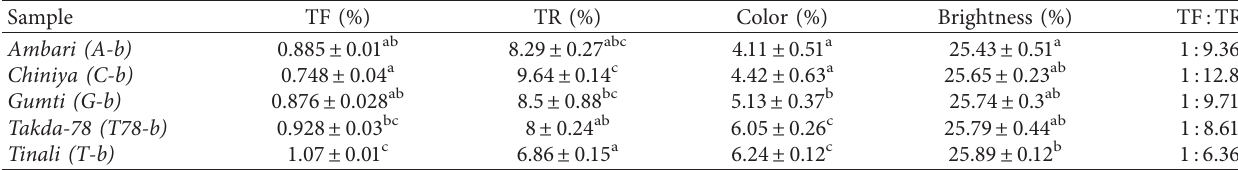
Table 6: Theaflavin (TF), thearubigin (TR), color, and brightness of black tea prepared from different clones of tea plant. Sample